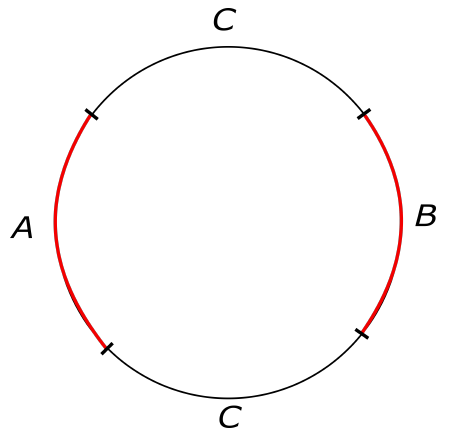
Figure 29: Schematic for the configuration of the disjoint intervals A and B separated by C such that the full tripartite system ABC is compact and is in a pure state